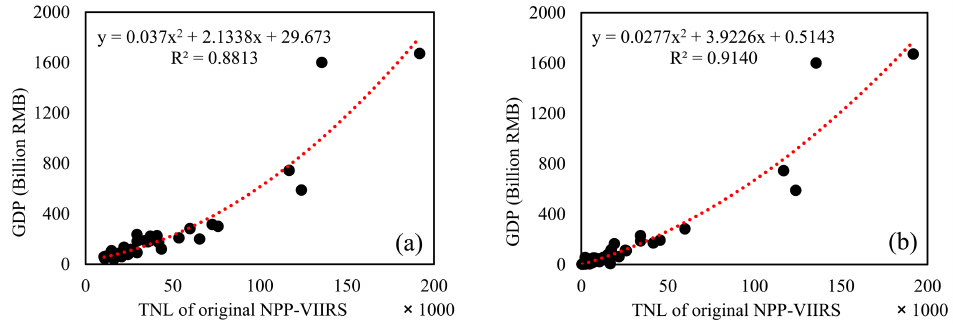
Figure 8. Statistical relationships between GDP and the total nighttime light (TNL) for the original VIIRS data at: ( a ) prefecture level; and ( b ) county level.